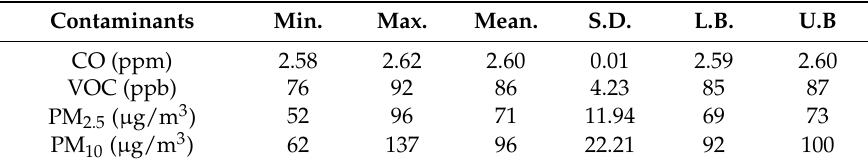
Table 3. Concentrations of different contaminants in the underground passageway. L.B. is the lower bound of 95% confidence interval; U.B. is the upper bound of 95% confidence interval. Contaminants Min. Max.